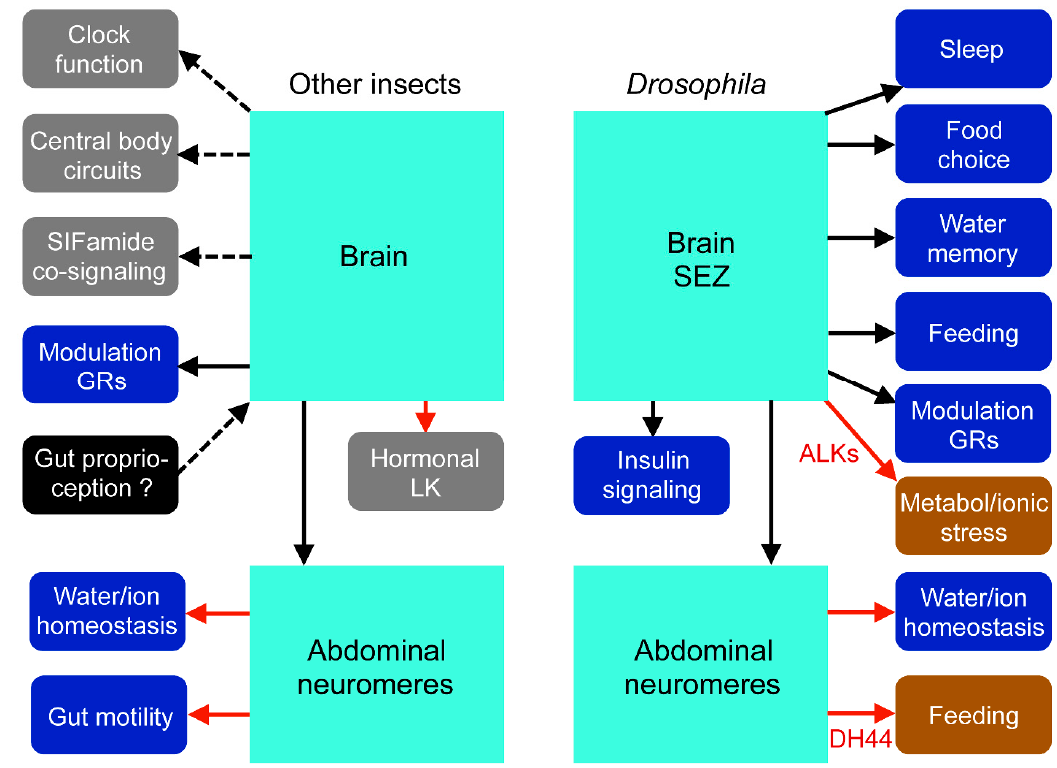
Figure 7. Summary of LK functions in Drosophila compared to other insects. In insects other than Drosophila , few functions have been explicitly determined (blue boxes), and most are suggested from LK expression (grey or black boxes). Red arrows indicate hormonal signaling, black arrows indicate established functions, and dashed arrows indicate suggested functions. In the mosquito A. aegypti , LK regulates sugar taste in gustatory receptor neurons (GRs) [138]; in the cockroach L. maderae and some other insects, intestinal contractions are regulated by LK; and in many insects, LK acts as a diuretic factor [75,133]. LK-expressing sensory cells in the intestine of L. maderae send axons to the frontal ganglion and brain, suggesting proprioceptive inputs [27]. In L. maderae , LK is present in pacemaker neurons of the clock circuit [27,93], and in the locust L. migratoria , LK is expressed in the four widely arborizing SIFamide-producing neurons and in circuits of the central body [34,83]. In several insects, including L. maderae , there are LK-expressing lateral and median neurosecretory cells indicating hormonal LK signaling from the brain [27,30,31]. In Drosophila , genetic interventions have revealed actions of specific neurons in the brain, subesophageal zone (SEZ), and abdominal neuromeres in several functional roles (blue boxes). These are metabolism–sleep interactions [100–103], food choice [131], water- and sugar-enforced memory [130], food intake, modulation of GRs [139,141], and water and ionic homeostasis [51,87,103]. One set of LK neurons (LHLKs) also regulates insulin-producing cells [51,103]. LK neurons expressing additional peptides contribute to other functions with non-LK peptides (red boxes). These are the ALK neurons that signal with LK, ITP, sNPF, and TKs and regulate metabolic and ionic stress responses (as well as feeding and drinking) [82,98], and ABLKs that also express DH44 and this peptide affect feeding and water balance